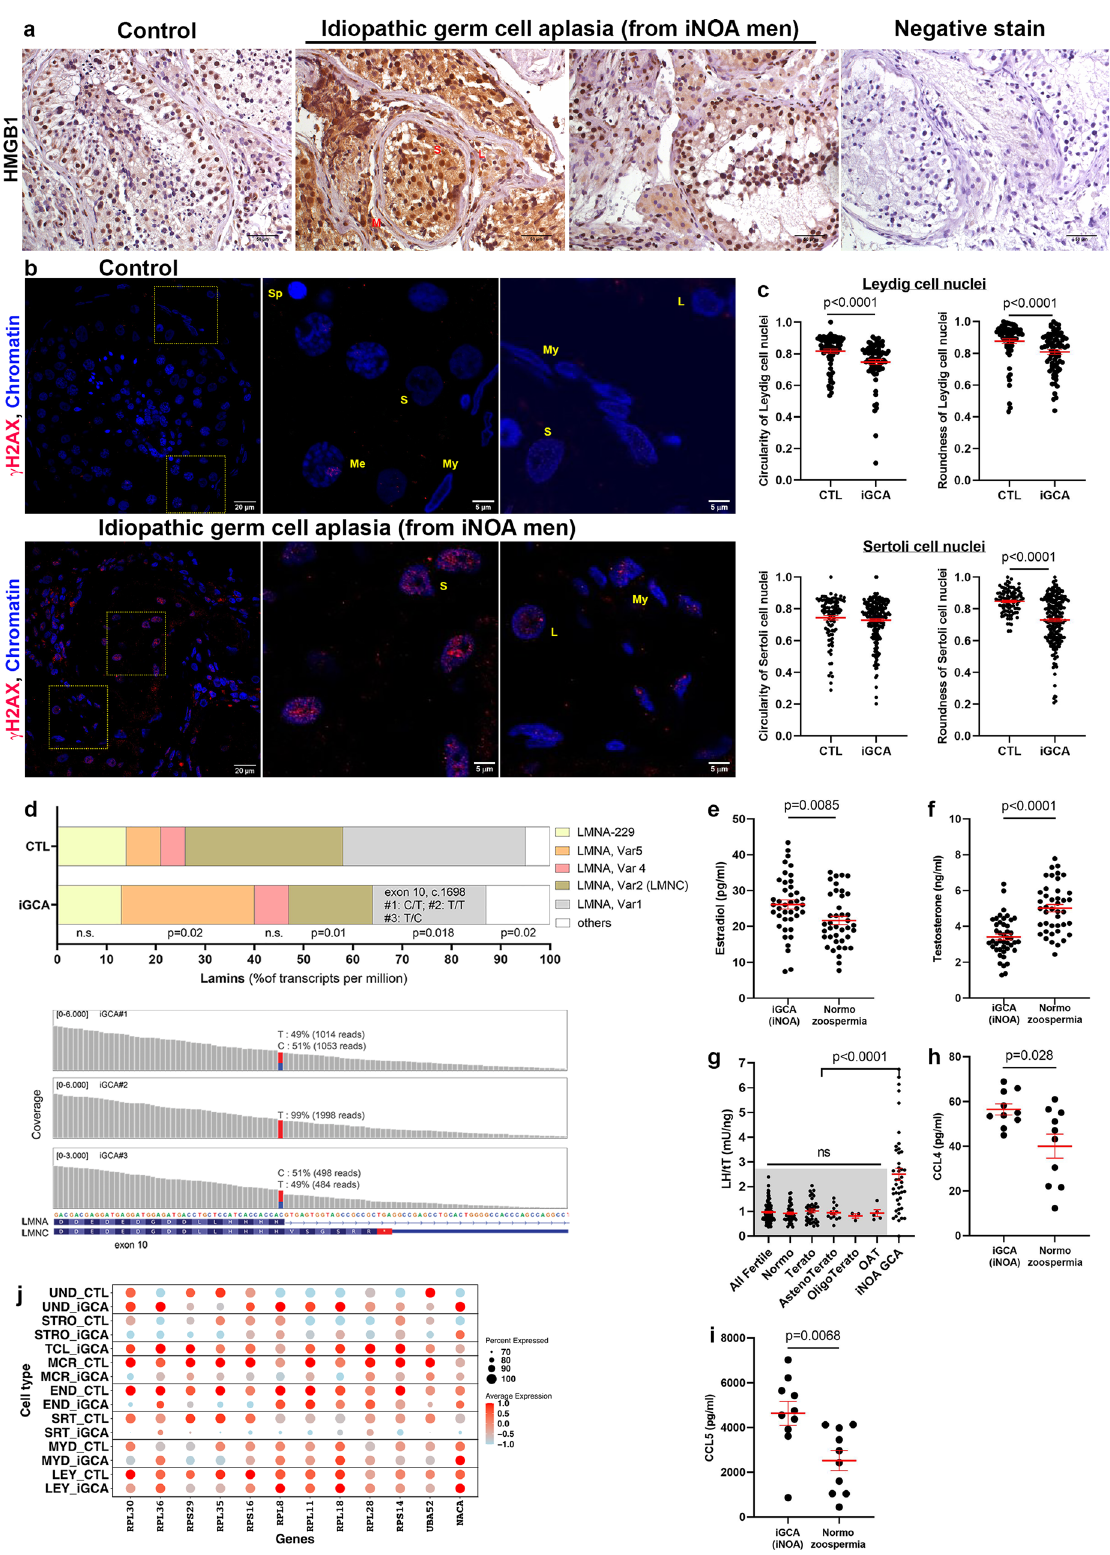
14, and 19), together with the unexpected biallelic expression of some pairs, expands the limited involvement of gene-speci fi c mechanisms 64 – 66 to a genomewide defect recalling multi-locus imprinting disturbances 67 as opposed to faulty methylation of speci fi c regions, worth to be characterized in the future. Any metabolic or environmental factors during embryo